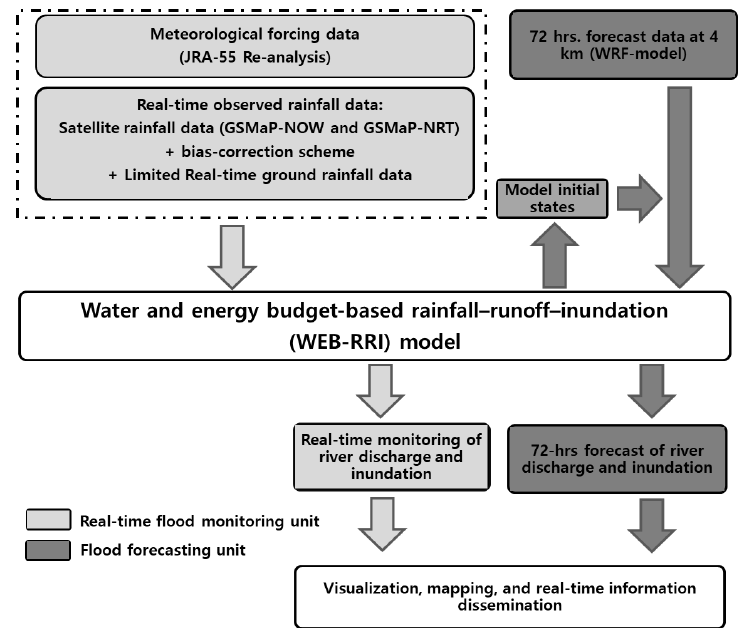
Figure 2. Schematic diagram of the research framework for the real-time flood monitoring, forecast- ing, and early warning systems. and early warning